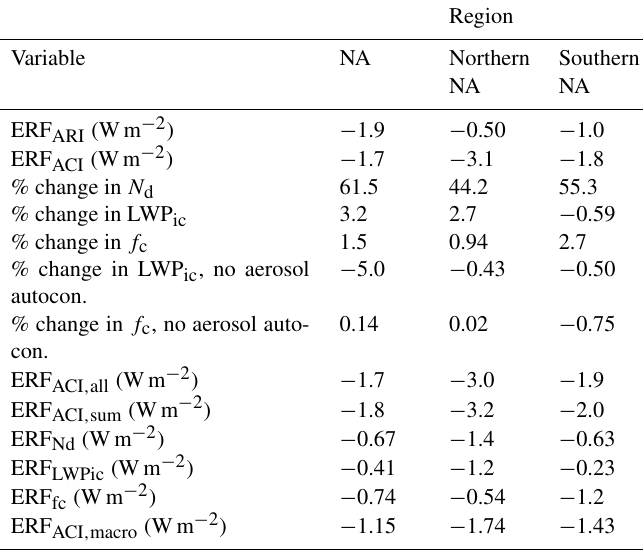
Table 3. Temporal and spatial means of various quantities for the whole NA domain and the various subregions. Values are shown for ERF ARI and ERF ACI , and the percentage changes in N d , LWP ic and f c between the PI and PD runs. Percentage f c changes are also shown for the runs with no aerosol effect on the rain autoconversion process. The other columns show results from the offline estimates of the ACI forcing. ERF ACI , all is the estimated forcing due to simultaneous PI to PD perturbations of N d , LWP ic and f c . ERF N are the forcing estimates from one-at-a-time perturbations of N d , LWP ic and f c , respectively, and ERF ACI , sum is the sum of these three forcing estimates. ERF ACI , macro is the forcing contribution from the cloud macrophysical changes, i.e. the sum of ERF LWP values are area weighted to account for the variation in area of the model grid boxes. Variable NA Northern ERF ARI (Wm − 2 ) − 1.9 − 0.50 −